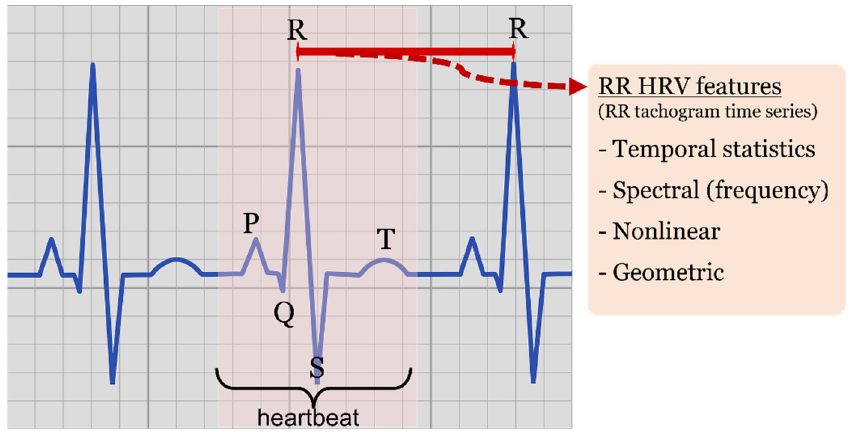
Figure 3. ECG representation. Highlighted heartbeat, PQRS wave points, RR interval (red) observed between QRS complexes and type of HRV features derived from RR time series (tachogram).